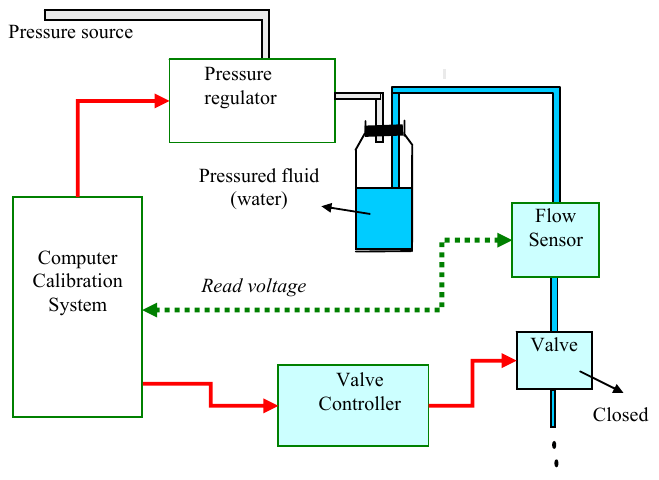
Figure 6. Experimental set up for pressure-voltage